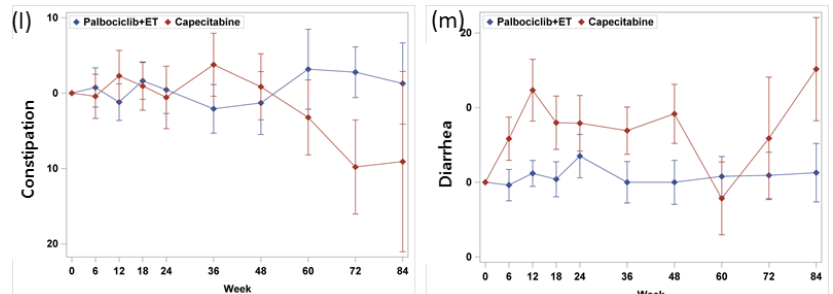
Figure 2. Change from baseline in EORTC QLQ-C30 function scales: ( a ) physical, ( b ) role, ( c ) emotion, ( d ) cognitive, ( e ) social function, symptom scales: ( f ) fatigue, ( g ) nausea and vomiting, ( h ) pain, and symptome scales: ( i ) dyspnea, ( j ) insomnia, ( k ) appetite loss, ( l ) constipation, and ( m ) diarrhea.